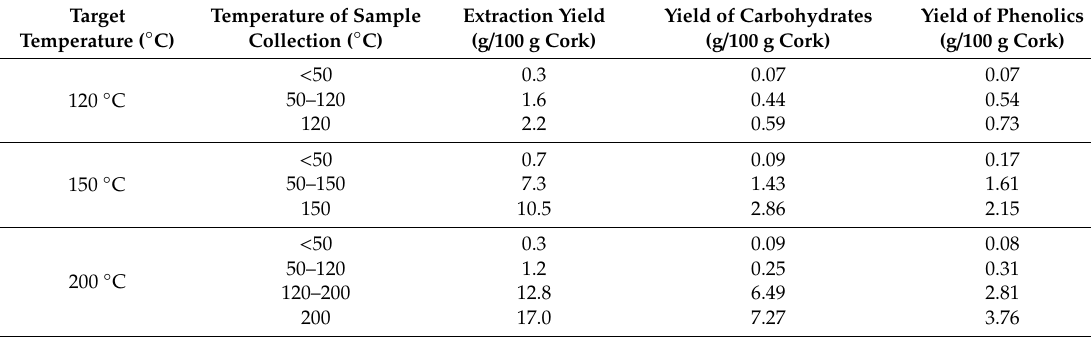
Table 3. Cumulative extraction yields of the SBW assays with granulated